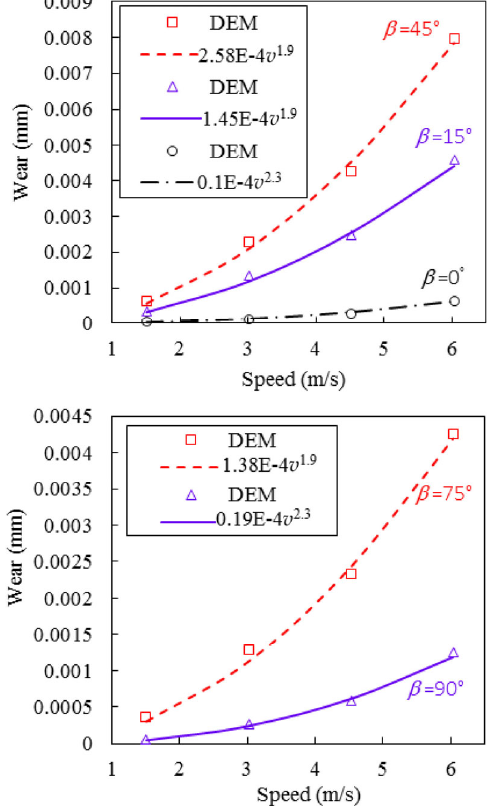
Fig. 18 Variation of the erosion versus the speed of the samples inside the particulate medium, along with the fitted power function (particle radius is 0.3 mm, and the other parameters are at their reference values).